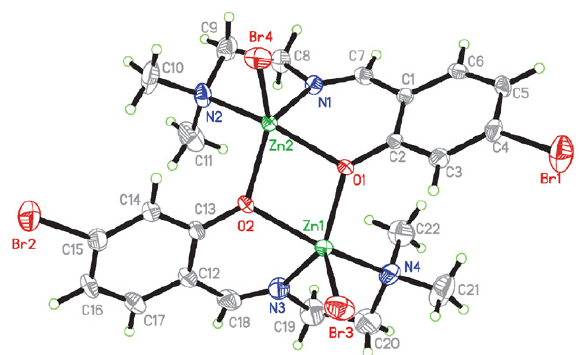
Fig. 1. Molecular structure of complex 1 .